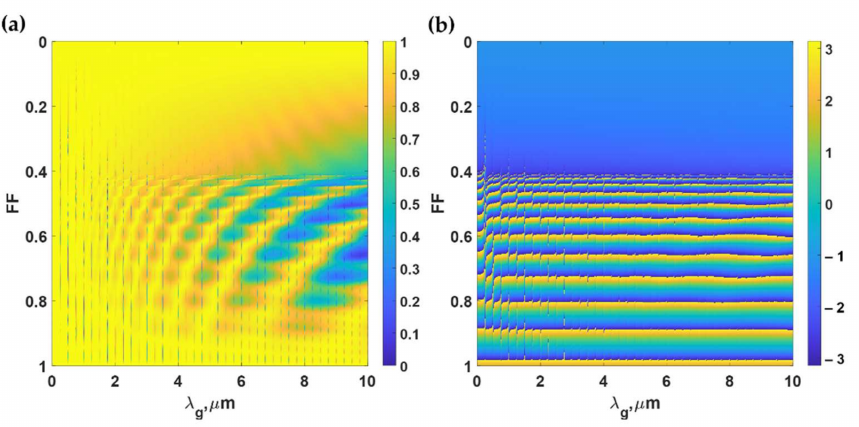
Figure 11. ( a ) Reflectance and ( b ) phase responses in rad of reflection coefficients calculated using RCWA for the PDMS gratings, when the gratings were varied the grating period λ g from 0 to 10 µ m, and the F.F. was varied from 0 to 1, and d of 11 µ m and d g of 9.75 µ m, when illuminated by TM polarized light at 685 nm and the n 0 sin θ 0 of 1.37.